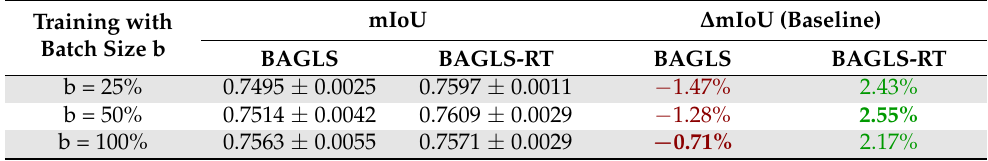
Table 2. Segmentation performance of the U-Net after incremental finetuning with BAGLS-RT. Training with